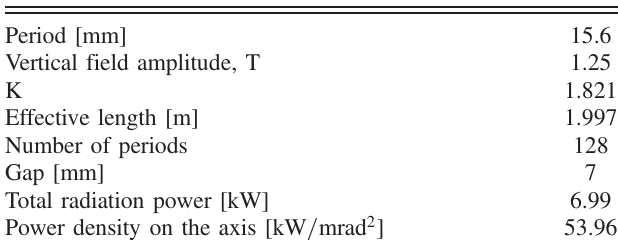
TABLE VII. rms alignment errors.